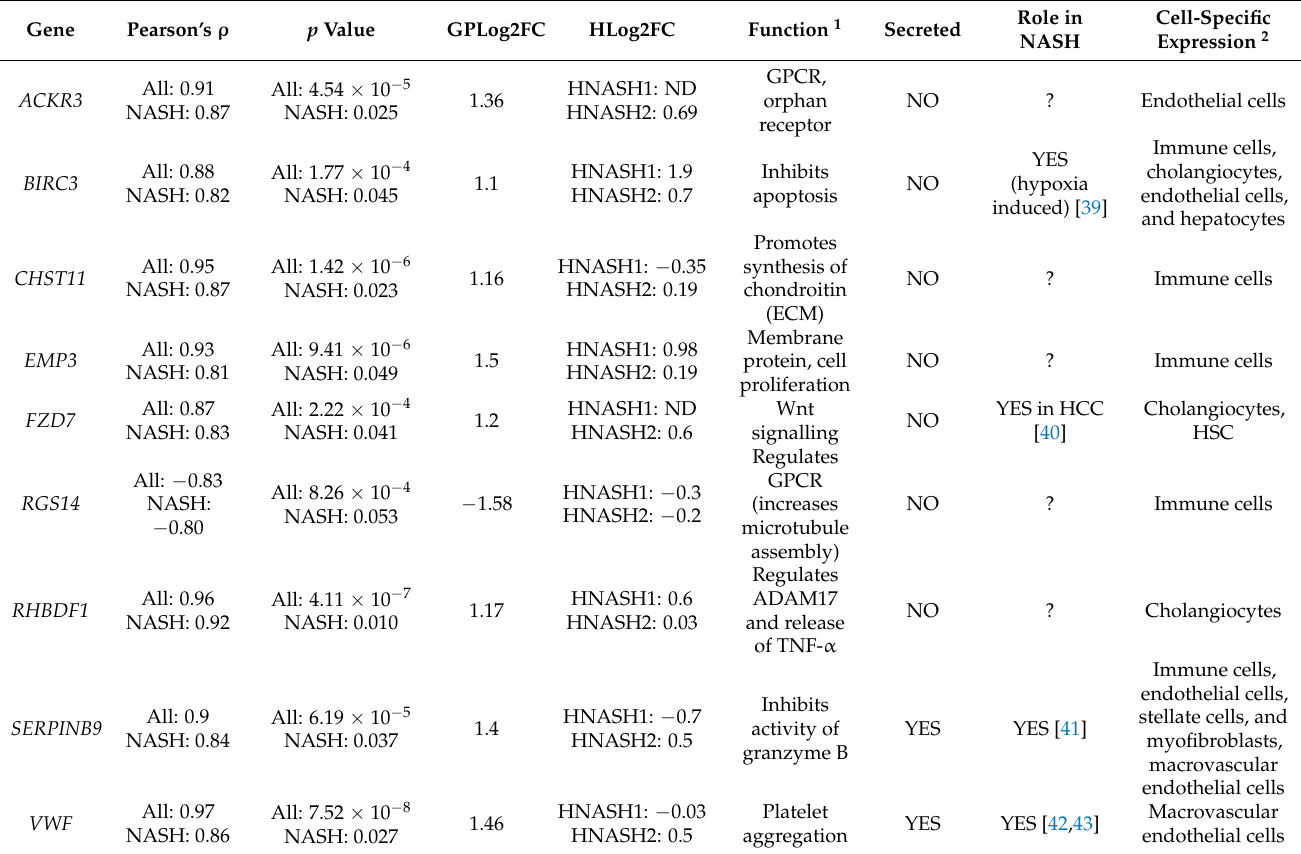
Genes listed in alphabetical order. In Pearson’s ρ column: All, correlation calculated using both control and NASH animals; NASH, correlation calculated using only NASH animals. 1 Description of function based on [44]. 2 Based on liver cell atlas [45,46]. ECM: extracellular matrix, GPCR: G-protein coupled receptor, GPLog2FC: guinea pig log2 fold change, HCC: hepatocellular carcinoma, HLog2FC: human log2 fold change, HSC: hepatic stellate cell, HNASH1: NASH patients with mild fibrosis vs. healthy controls. HNASH2: NASH patients with advanced fibrosis vs. NASH patients with no or mild